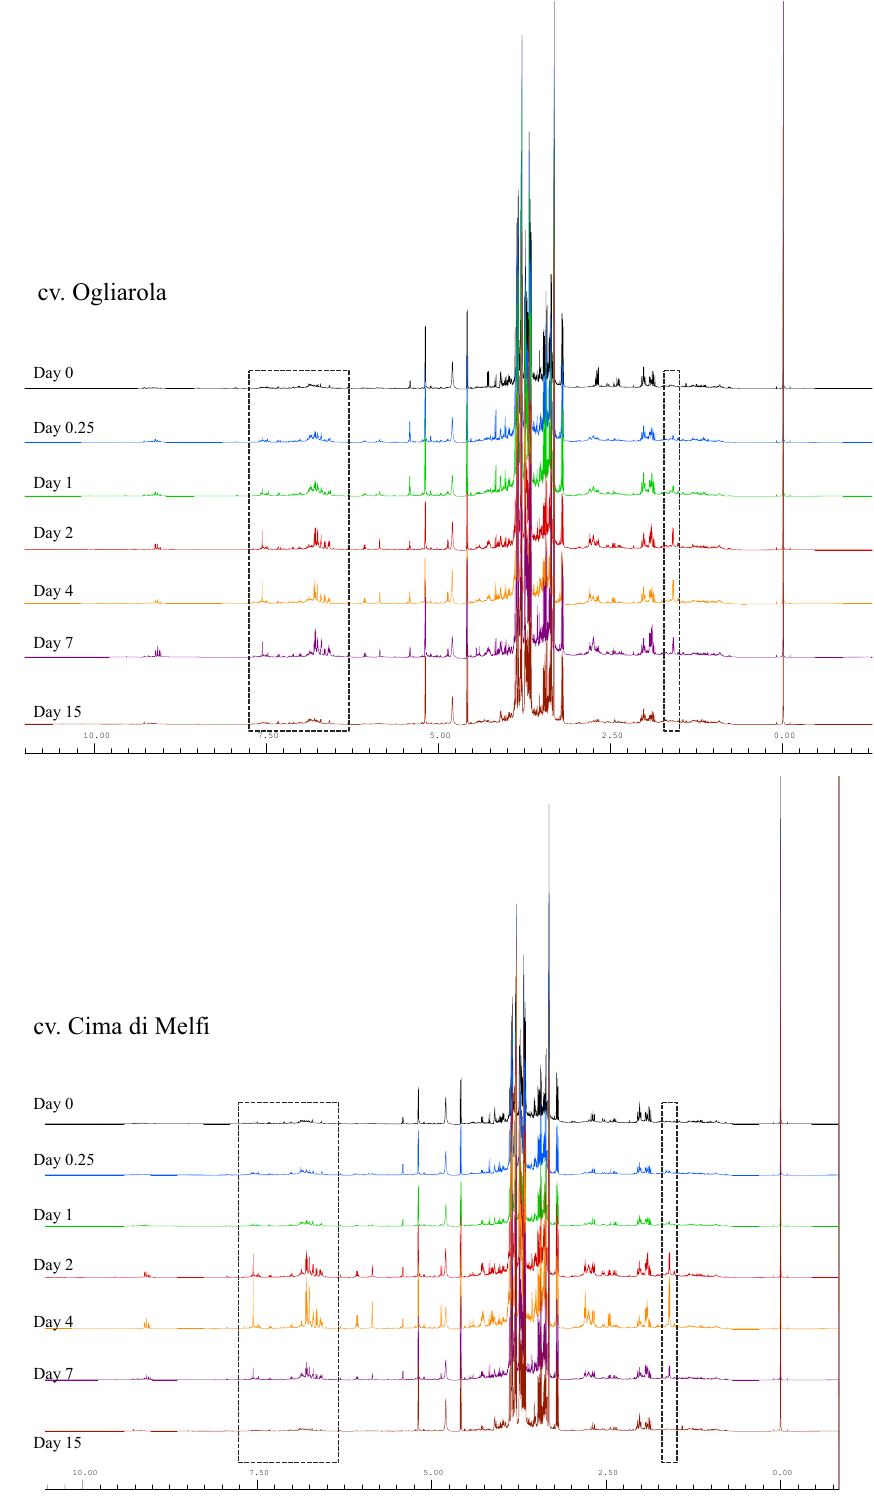
Figure 5. Stacked plot of 1 H NMR spectra of leaf sample extract at different day from the injection for Ogliarola salentina and Cima di Melfi cultivar trees. The increase of the oleuropein signals intensity was